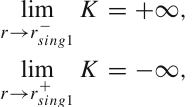
From Eqs. (38) and (40) we get A and B for α = − 1. From this equation we can get g rr = e 2 B and g tt = e 2 B